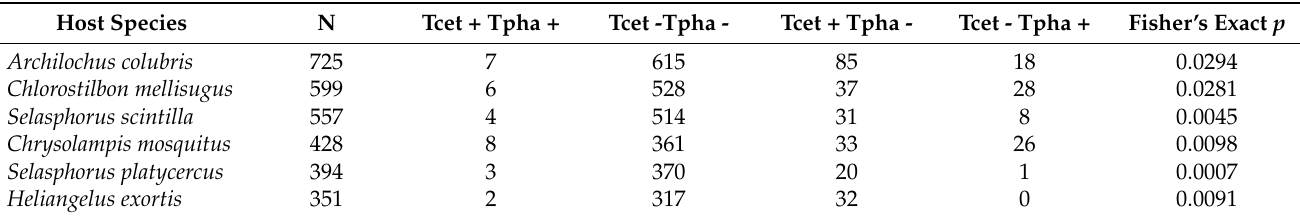
Table 4. The association of Trochiliphagus and Trochiloecetes lice was significantly more frequent than expected by chance in six hummingbird species.